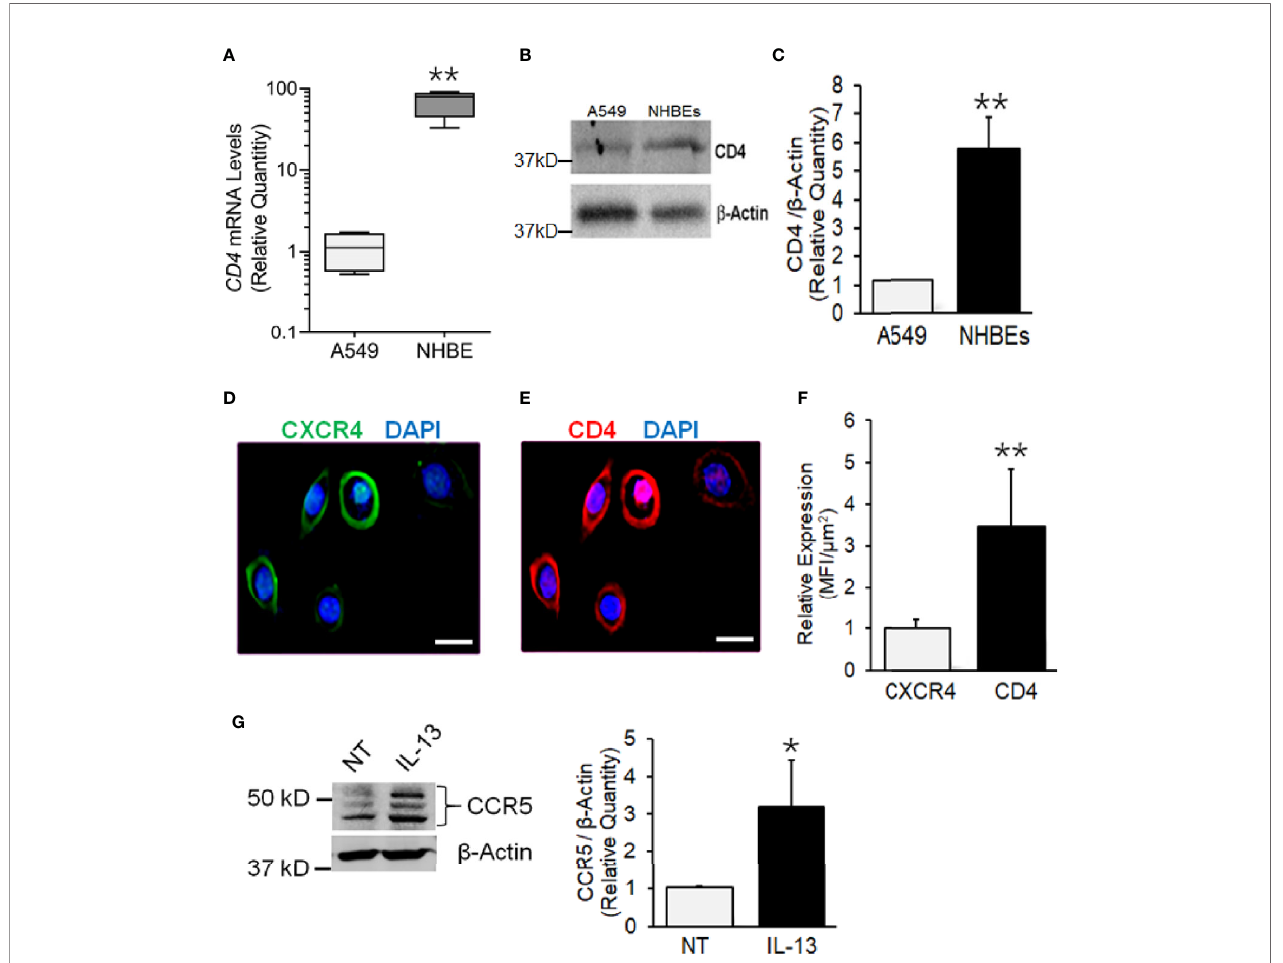
FIGURE 1 | Human airway epithelial cells express HIV receptor and co-receptors. (A) qPCR analysis of CD4 mRNA levels in NHBEs compared to A549 cells. (B) Western blot analysis of CD4 protein levels in NHBE and A549 cells with b -actin as the loading control. (C) Densitometric analysis of CD4 protein levels compared to A549 cells. Representative micrographs of NHBE cells showing (D) CXCR4 (green) and (E) CD4 (red) immunopositivity along with DAPI-stained nuclei (blue); scale — 5µ. (F) Relative expression of CXCR4 and CD4 in NHBEs as assessed by measuring the Mean Fluorescence Intensity (MFI) per unit area. (G) Western blot analysis of CCR5 protein levels in NHBE cells treated with IL-13 (1 ng/ml) for 48 h compared to non-treated (NT) control cells and densitometric analysis of CCR5 levels normalized to b -actin levels compared to controls. Data shown as mean ± SEM; n = 3/group and are representative of three different experiments; *p < 0.05; **p <